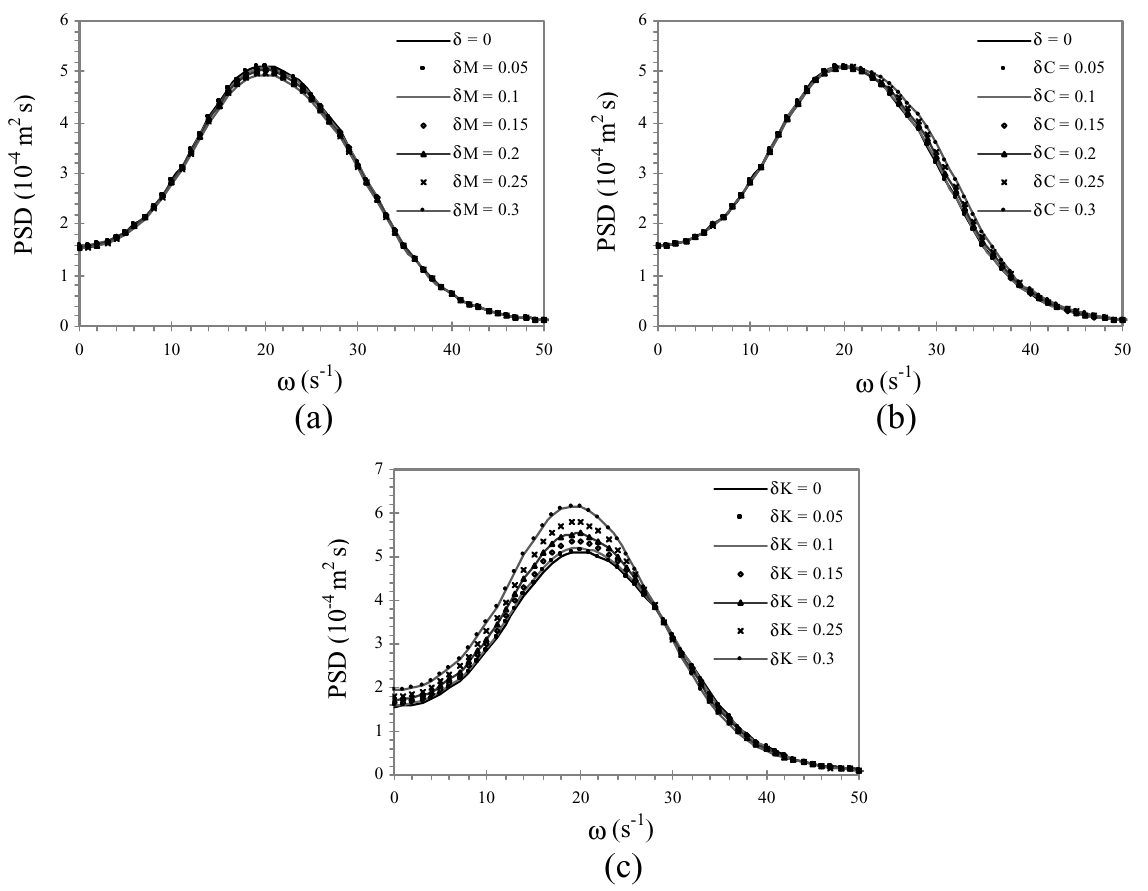
Fig. 5. PSD curves of Y 20 for independently varying stochastic matrices for: (a) mass; (b) damping and; (c)